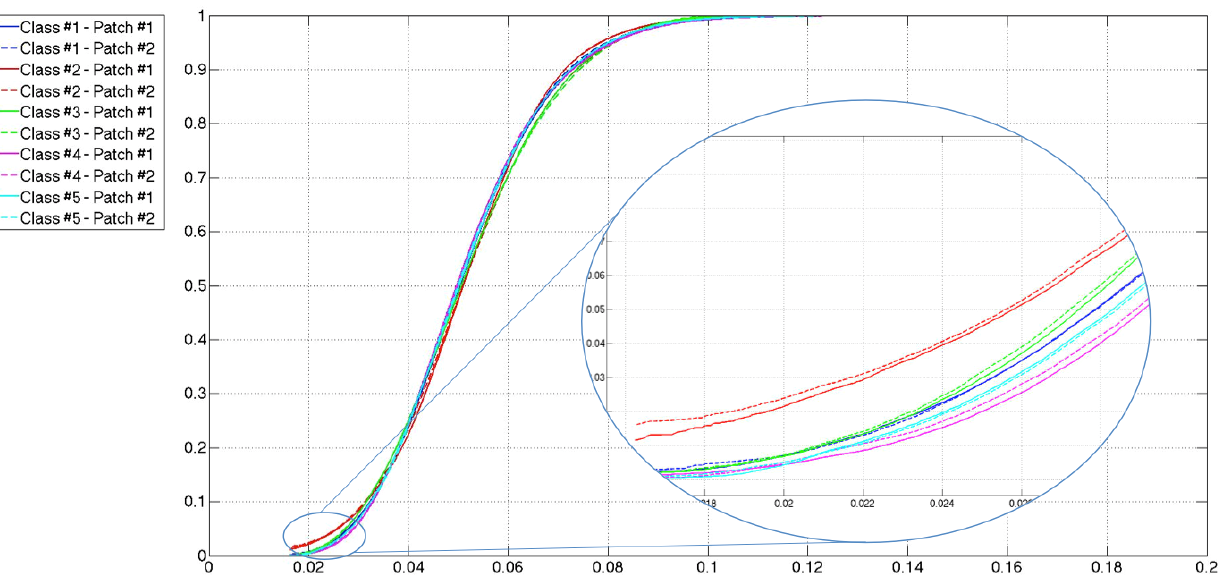
Figure 14. Gamma cumulative distribution functions of representative patches of each